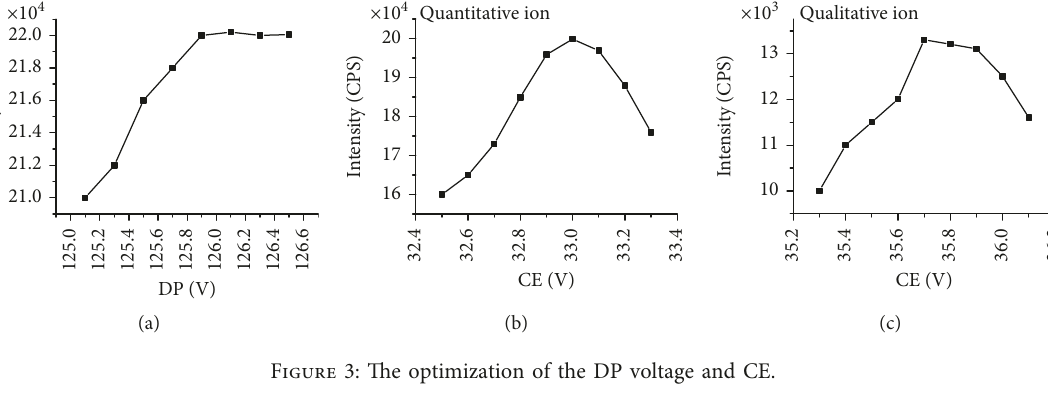
Figure 3: The optimization of the DP voltage and